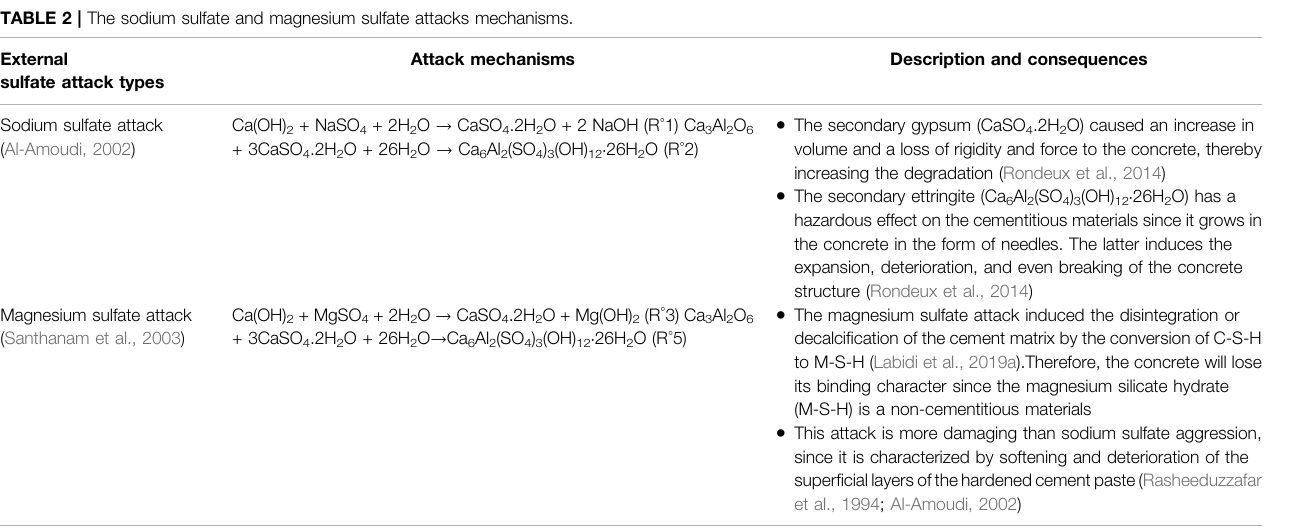
TABLE 2 | The sodium sulfate and magnesium sulfate attacks